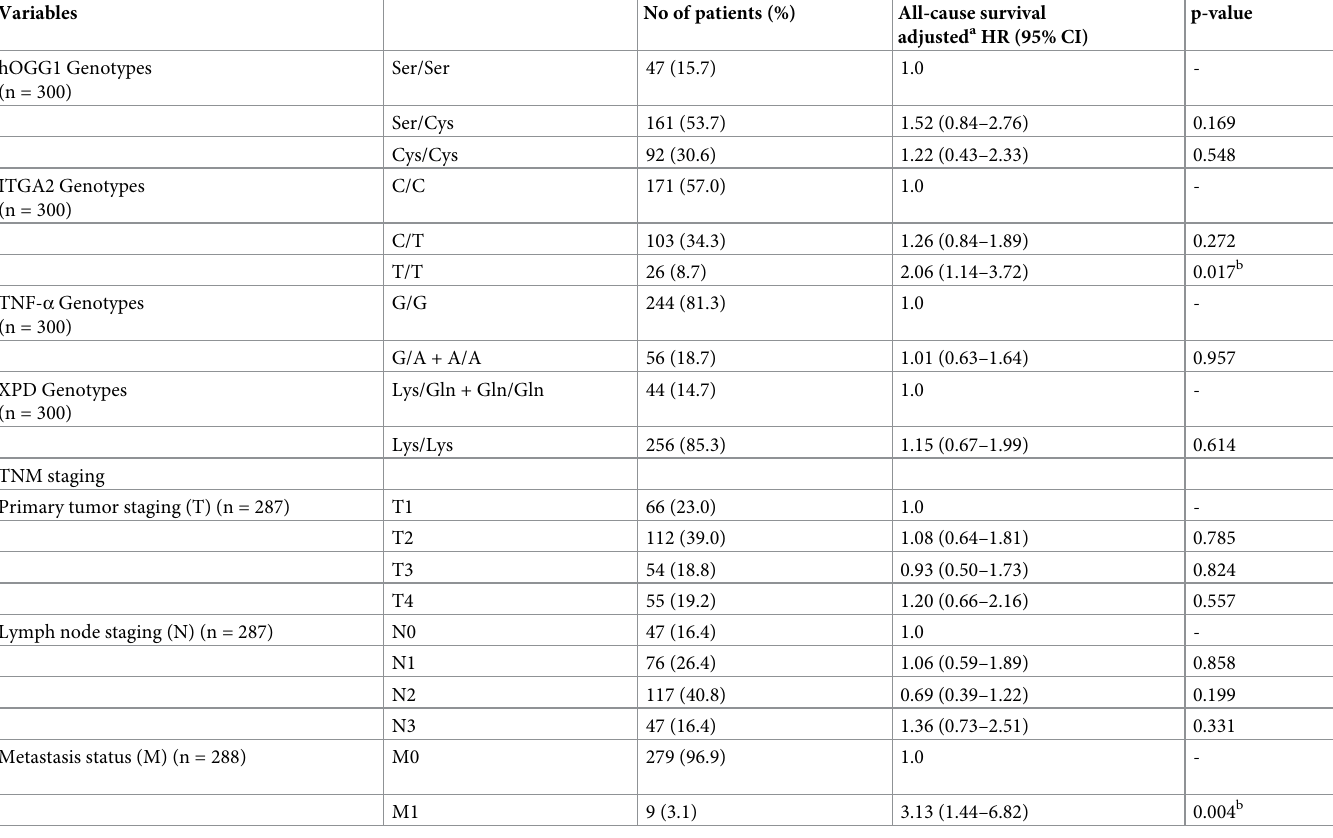
Table 4. Gene polymorphisms and TNM staging with the all-cause survival (N = 300) analyzed individually using Cox